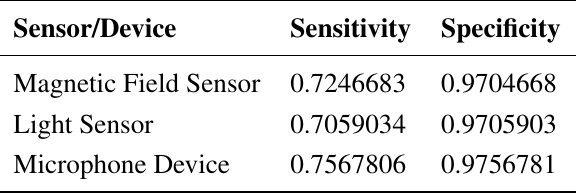
Table 2. Comparison of sensitivity and specificity: summer